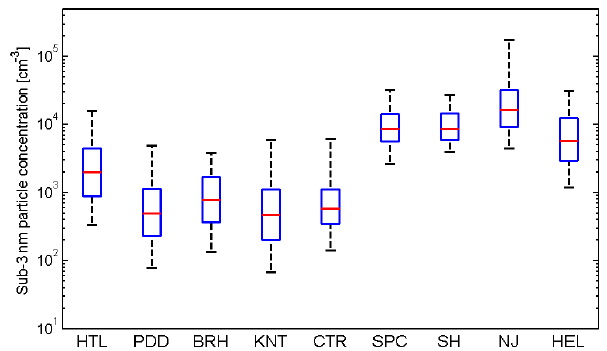
Figure 2. The variation in sub-3nm particle concentration at differ- ent measurements sites. The red lines show the medians, the blue boxes indicate the 25th and 75th percentiles, and the vertical bars show the 5th and 95th